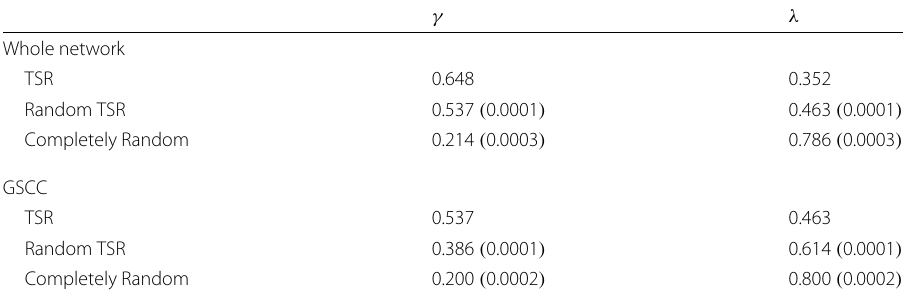
Table 3 Gradient ratio γ and loop ratio λ for the whole network and the GSCC of the TSR transaction network